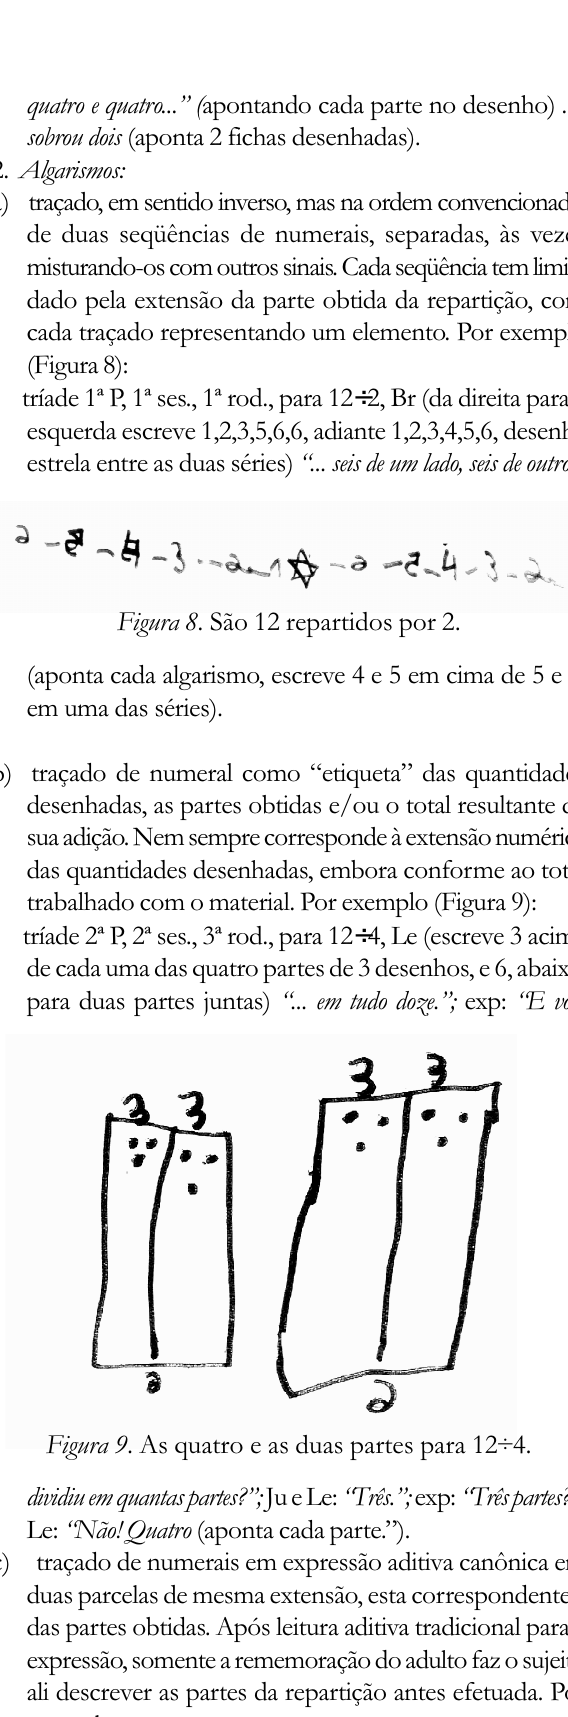
Psicologia: Reflexªo e Cr(cid:237)tica, 2004,